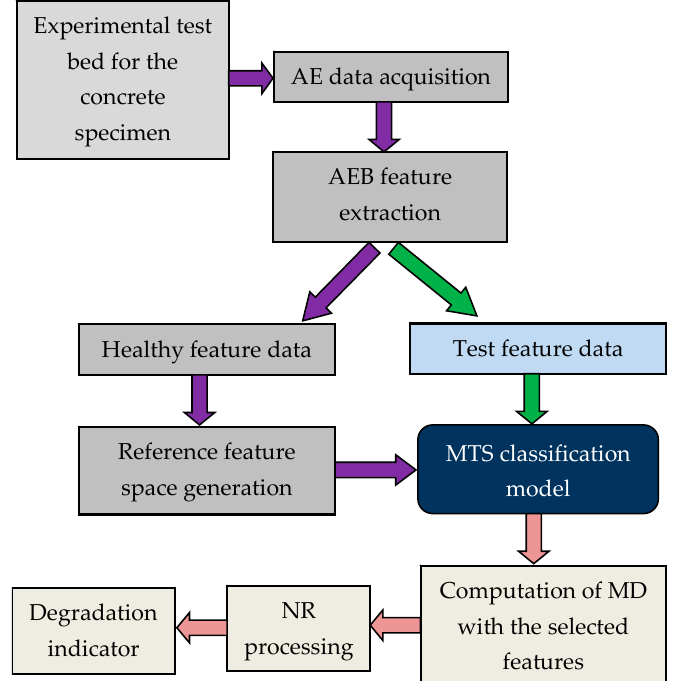
Figure 7. Proposed framework for building degradation indicator (DI) for degradation assessment of concrete beams.